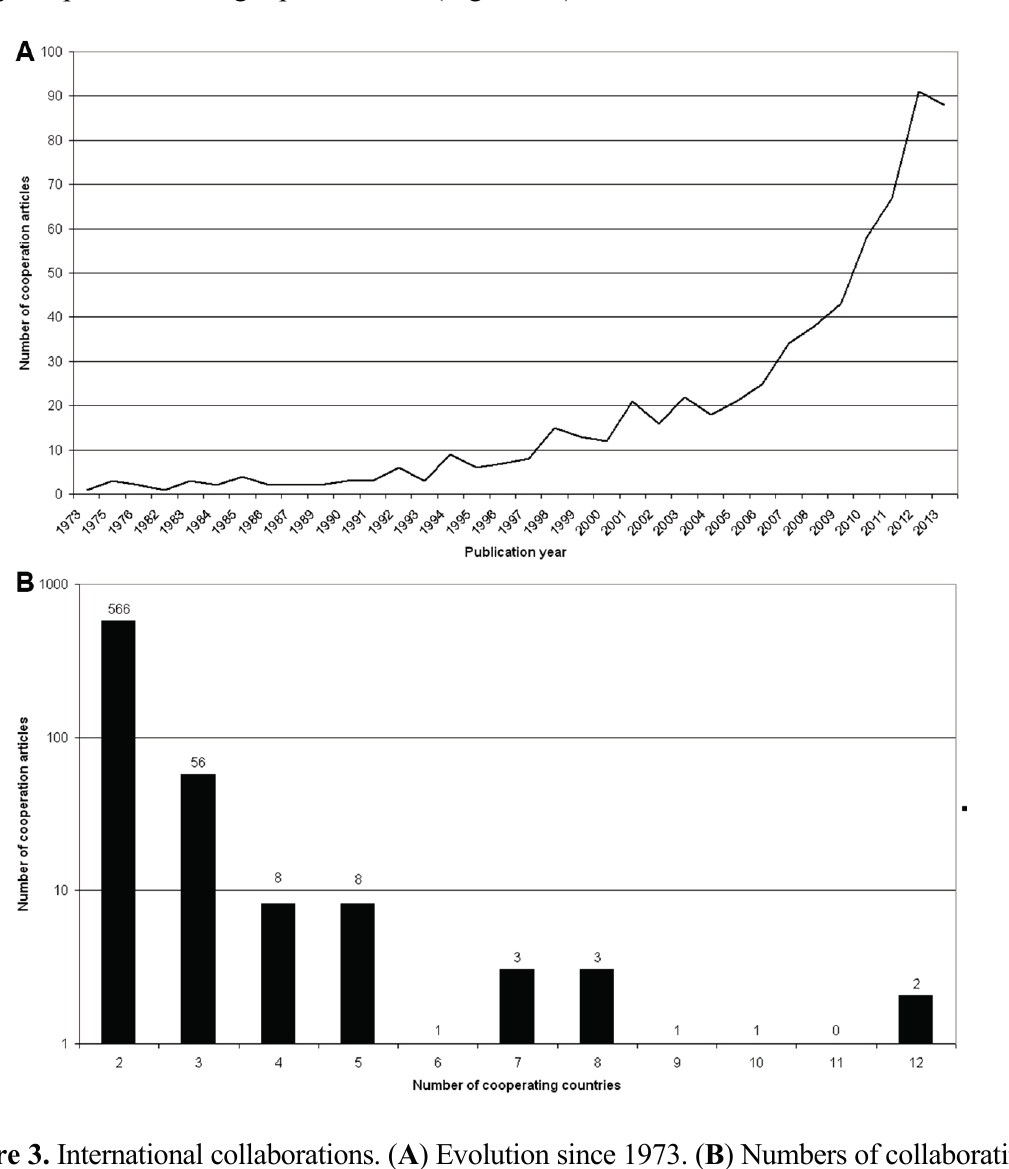
Figure 3. International collaborations. ( A ) Evolution since 1973. ( B ) Numbers of collaborating countries